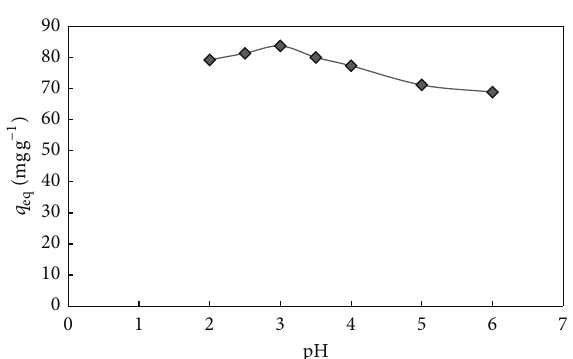
Figure 2: The effect of initial pH on the adsorption of TB AGLF by sunflower pulp ( 𝑇 : 25 ∘ C, 𝐶 0 : 100 mgL −1 , 𝑋 : 1.0 gL −1 , and agitation rate: 150rpm).